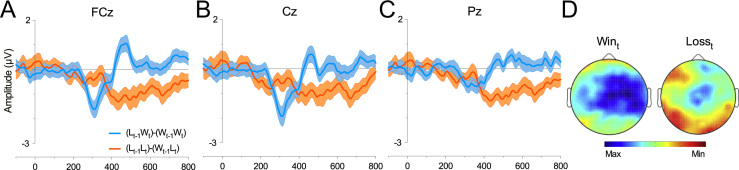
Wint and Losst FRN difference. Difference waveform computed by subtracting Wint−1Wint from Losst−1Wint trials (blue) and Losst−1−Losst from Wint−1−Losst (orange) trials at FCz (A), Cz (B) and Pz (C). Error bars represent SE and abscissa shows time in milliseconds. (D) Topographical maps display mean difference at each electrode site for the FRN time window for Wint and Losst (−1.1 to 0.6 µV).